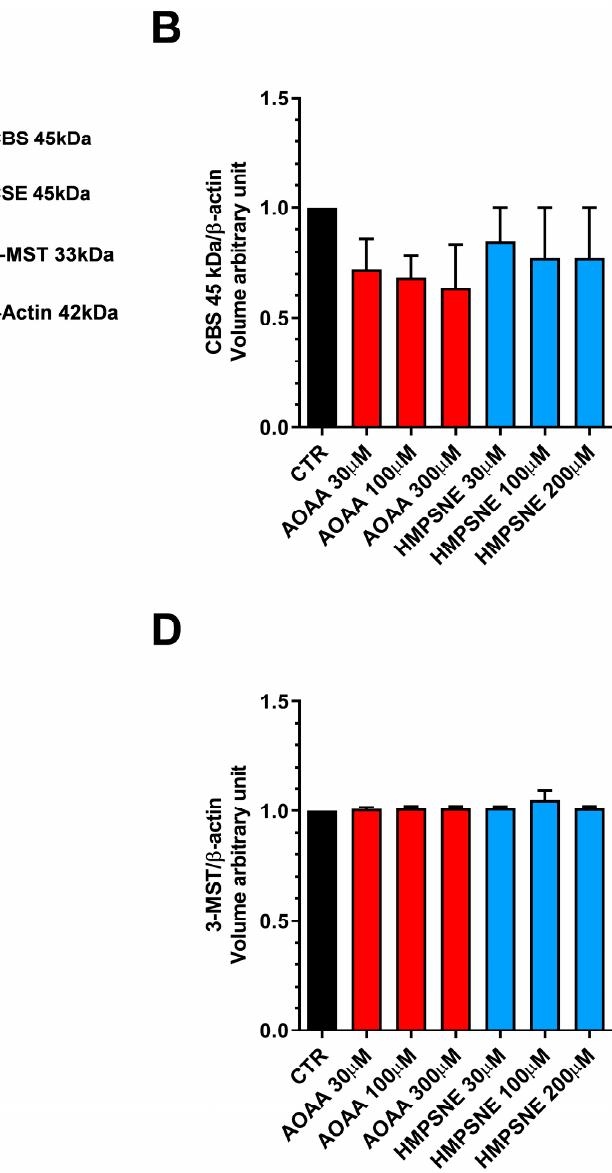
Figure 1. Expression profile of the H 2 S-synthesizing enzymes (CBS, CSE, and 3-MST) in EO771 cells. Expression levels were analyzed by Western blotting. Representative Western blot images of EO771 treated with different concentrations of AOAA or HMPSNE for 24 h and corresponding densitometry analysis ( A – D ). β -Actin was used as loading control. N = 4 independent experiments ± SEM. We also assessed whether AOAA or HMPSNE affect the expression of these en- zymes after incubation for 24 or 48 h. No statistically significant effects were detected (Figures 1 and